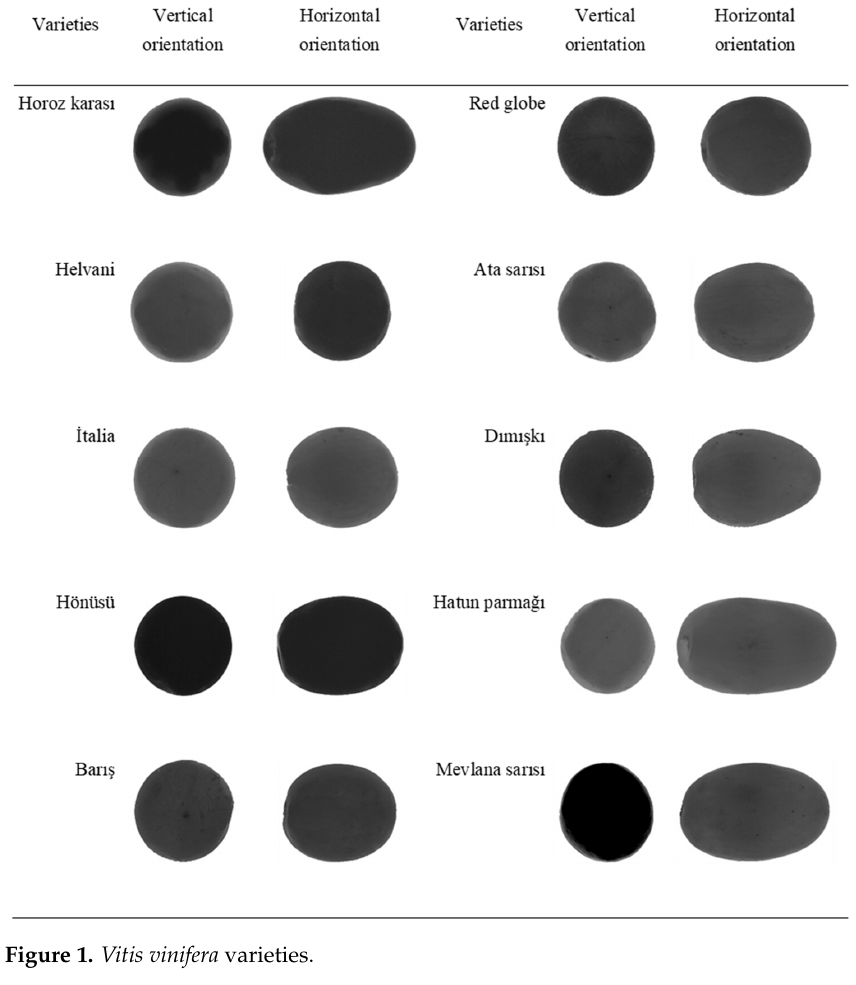
Figure 1. Vitis vinifera varieties.